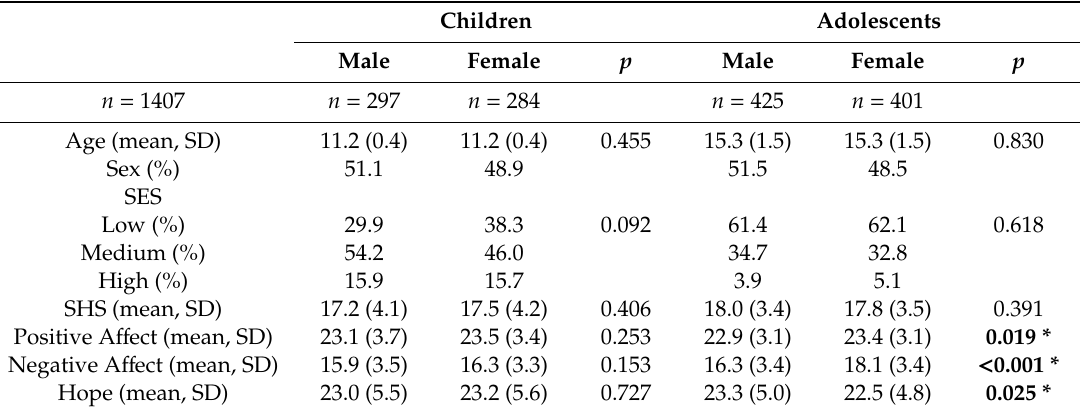
Table 1. General characteristics of the study sample.